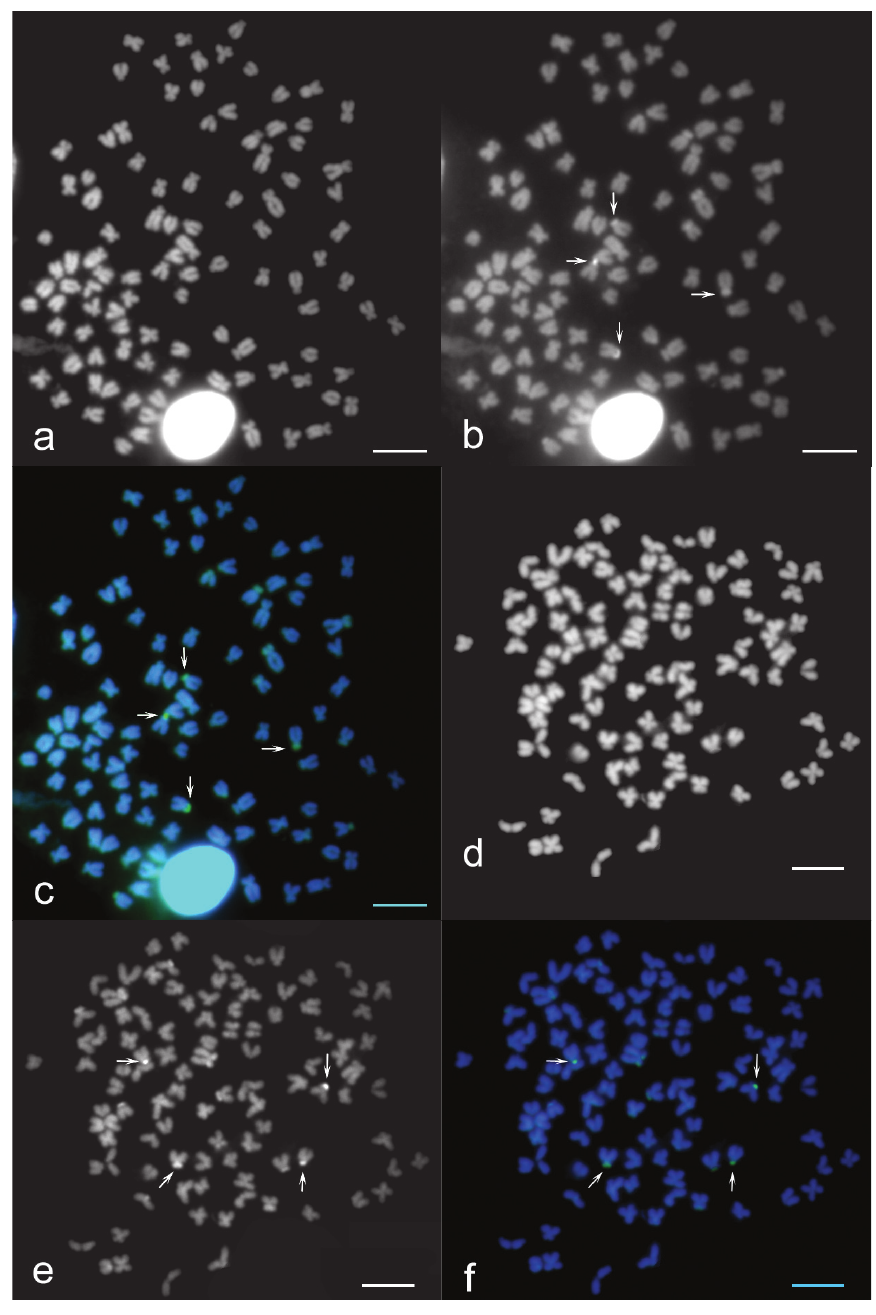
Figure 2. a–f Sequential chromosome banding of C. carassius female chromosomes. Metaphases coun- terstained by DAPI show all 100 chromosomes ( a , d ), metaphases stained by CMA ( b, e white arrows) and the combination of these bandings show 4 identical NORs ( c, f white arrows; green signals). Bar = 10